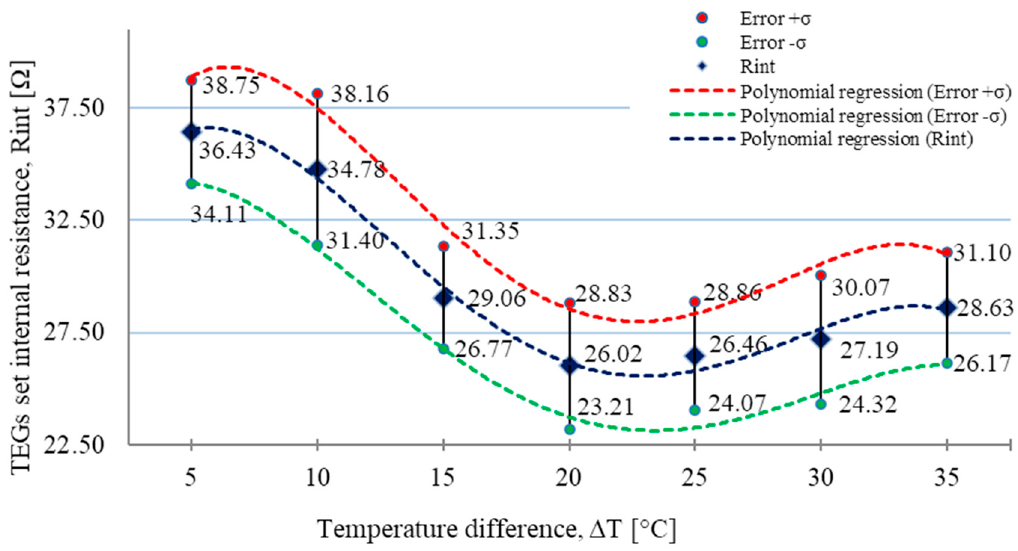
Figure 8. TEG set internal resistance as a function of temperature difference.